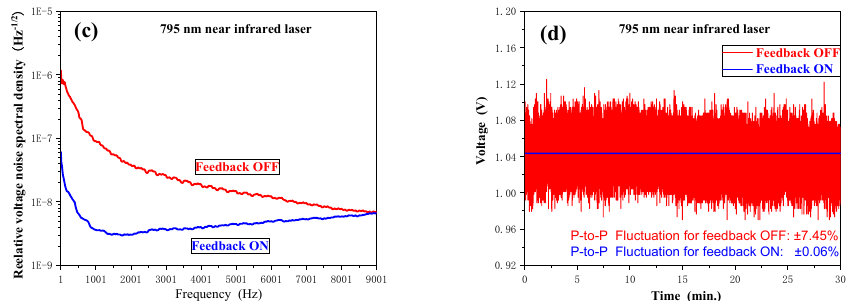
Figure 2. Comparison of laser intensity noise of the 795-nm NIR laser for feedback system on and off with different feedback bandwidths. The effective feedback bandwidth is ~60.0 kHz for ( a ) and ( b ), and ~9.0 kHz for ( c ) and ( d ), respectively. In time domain, typical peak-to-peak fluctuation of 795-nm NIR laser intensity is improved from ± 7.45% to ± 0.54% ( b ) and ± 0.06% ( d ), respectively. The 795-nm NIR laser intensity’s stability is improved by a factor of ~13 ( b ) and ~120 ( d ), respectively.